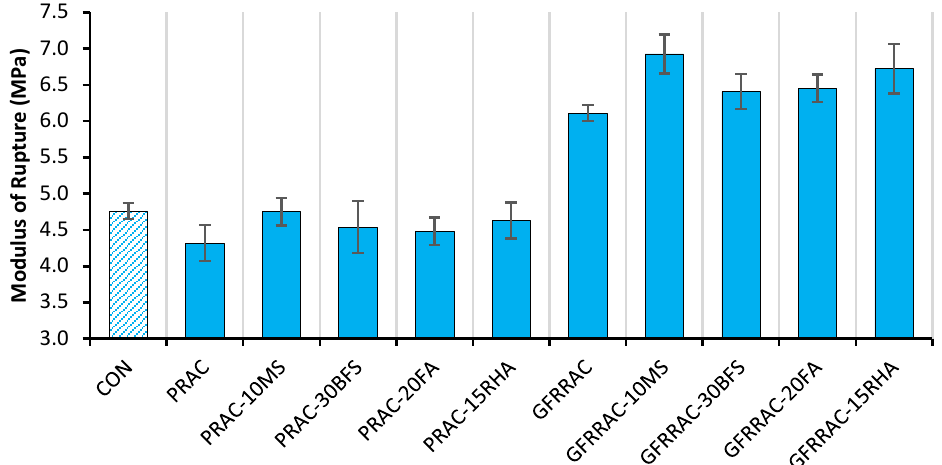
Figure 14. The effect of mineral admixtures and glass fibers on the modulus of rupture (MOR) of RAC.